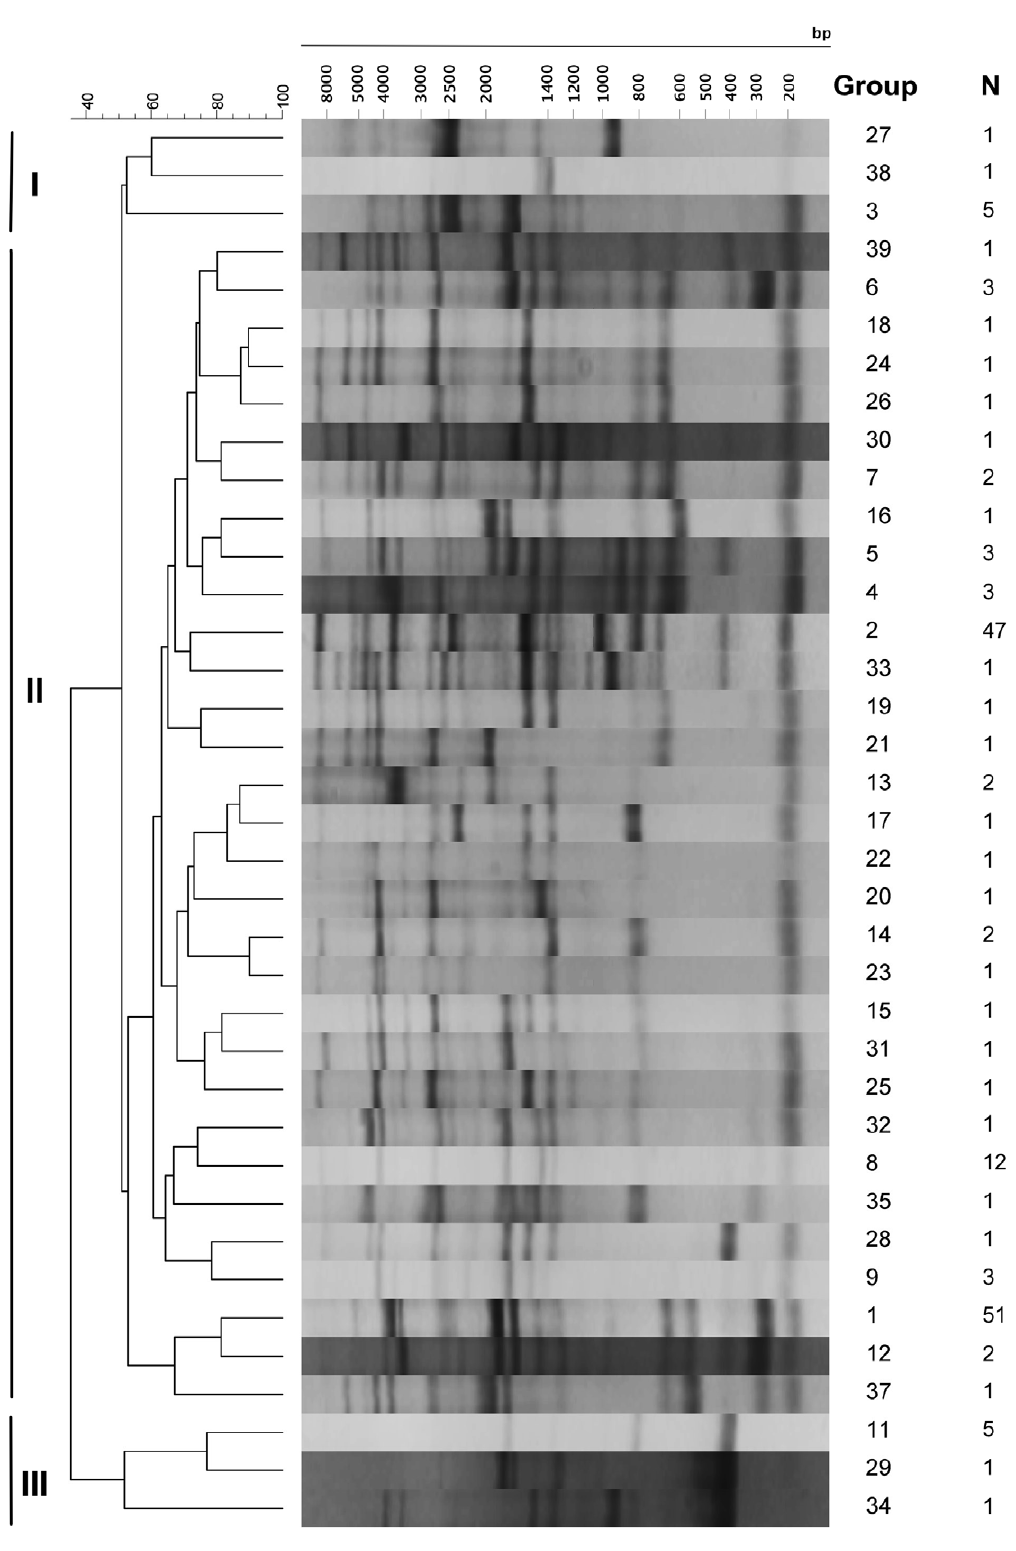
Figure 1. REP-PCR patterns and representative dendrogram. The electrophoresis banding patterns of 167 V. parahaemolyticus isolates assayed by REP-PCR is shown. BioNumerics analysis of patterns revealed 39 unique REP-PCR groups comprised of N isolates. The corresponding BioNumerics dendrogram illustrates the genetic relatedness between REP-PCR groups, which we grouped into three major clusters (I, II, III). Groups 27, 28 and 3 comprise cluster I while groups 11, 29 and 34 comprise cluster III and all remaining groups comprise cluster II. Electrophoresis banding patterns shown with scale indicating fragment size in base pairs (bp).